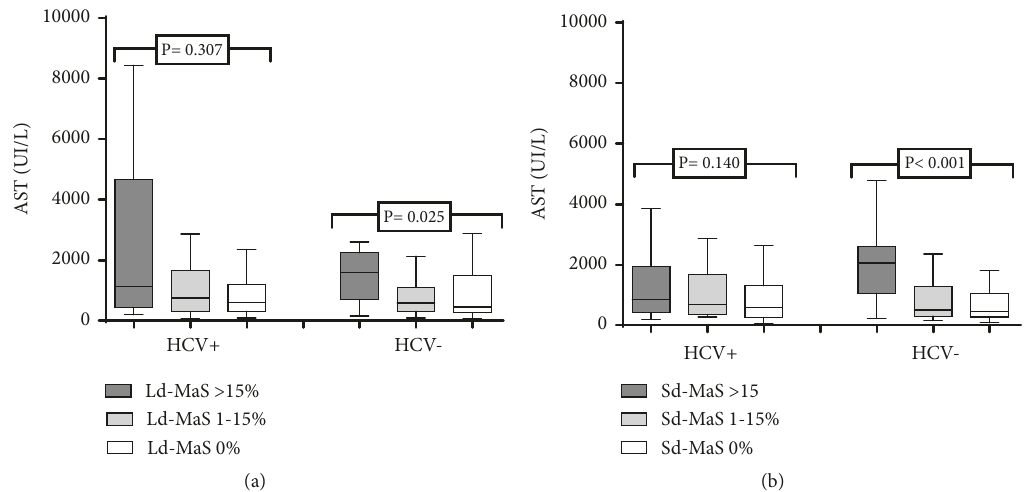
Figure 5: First three days after operative serum AST peak according to graft large droplet (Ld-MaS) and small-droplet (Sd-MaS) macrovesicular steatosis distribution in recipients with HCV unrelated (a) and related (b) liver disease.